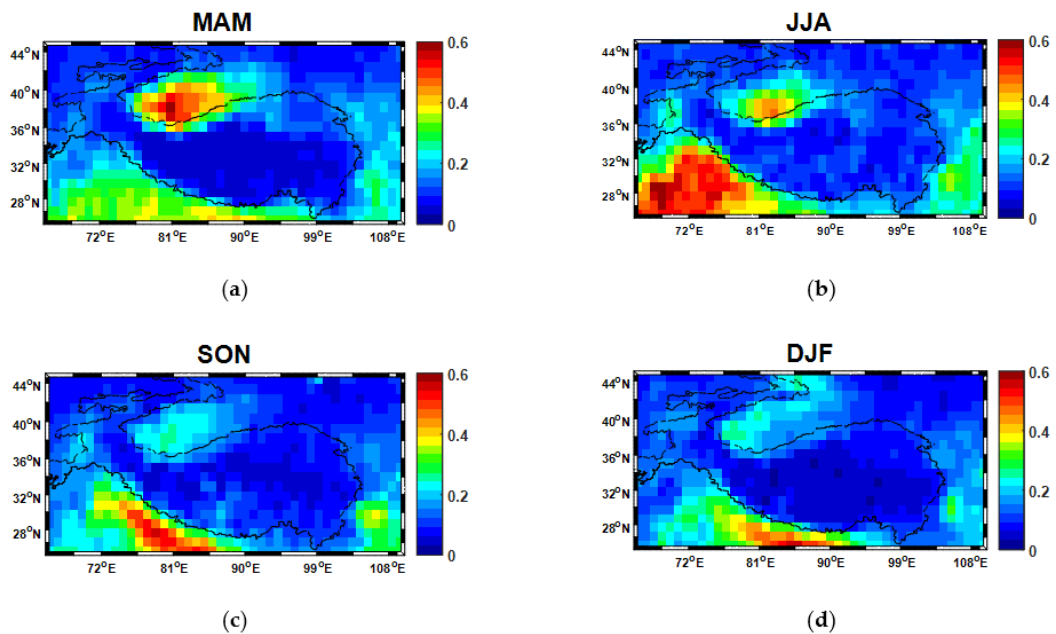
Figure 7. Seasonal maps of the lowest aerosol layer AOD (AOD 1 ) over the TP: ( a ) spring, ( b ) summer, ( c ) fall, and ( d ) winter over the eight-year data period from January 2007 to December 2014 (The AOD is at 532 nm and the map is gridded at 1°).